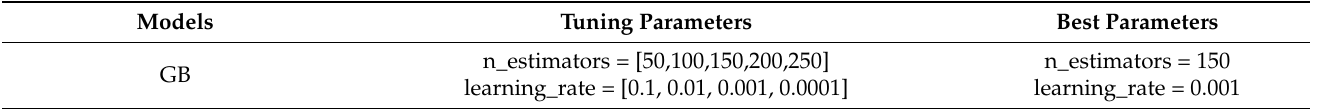
Table 4. The best parameters for the gradient boosting model using a genetic algorithm. Models Tuning Parameters Best